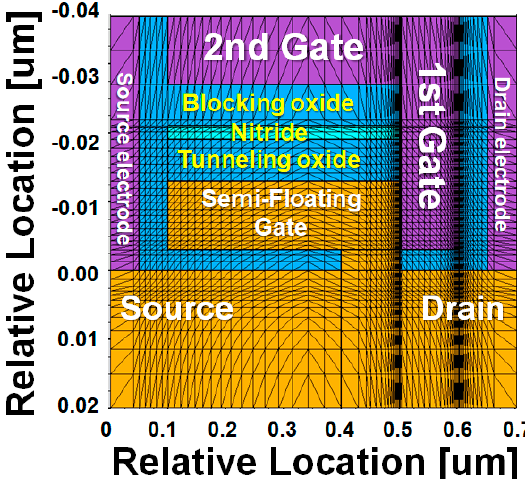
Figure 2. Device structure and potentiation process. ( a ) Aerial view of the proposed synaptic device and its circuit symbol representation; ( b ) Cross-sectional view of the device; ( c ) Contour of hole current density during the potentiation through band-to-band tunneling.